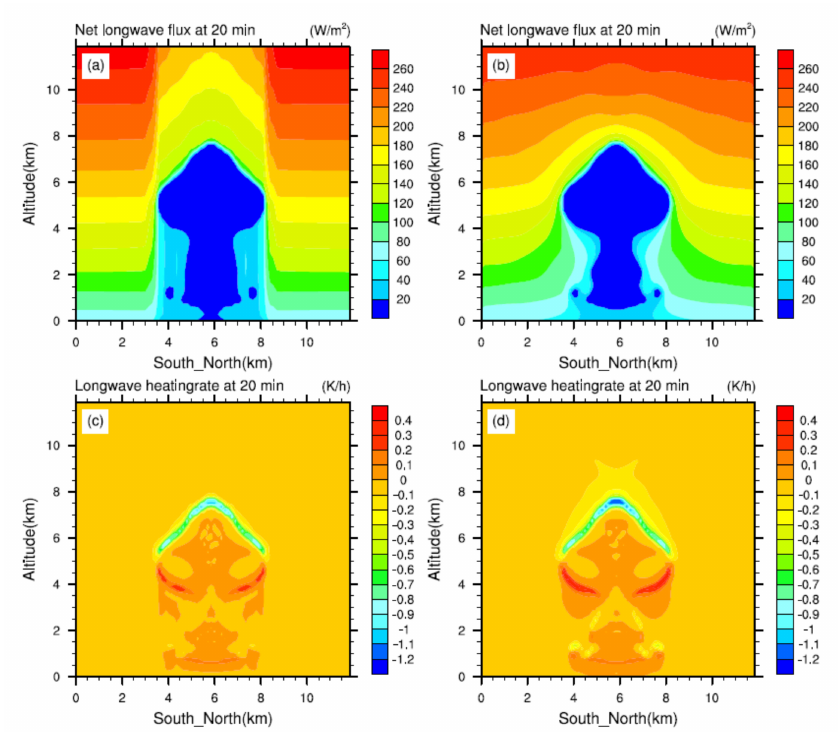
Figure 6. Net longwave radiation flux and Longwave heating rate in the 1D radiation case ( a , c ) and the 3D radiation case ( b , d